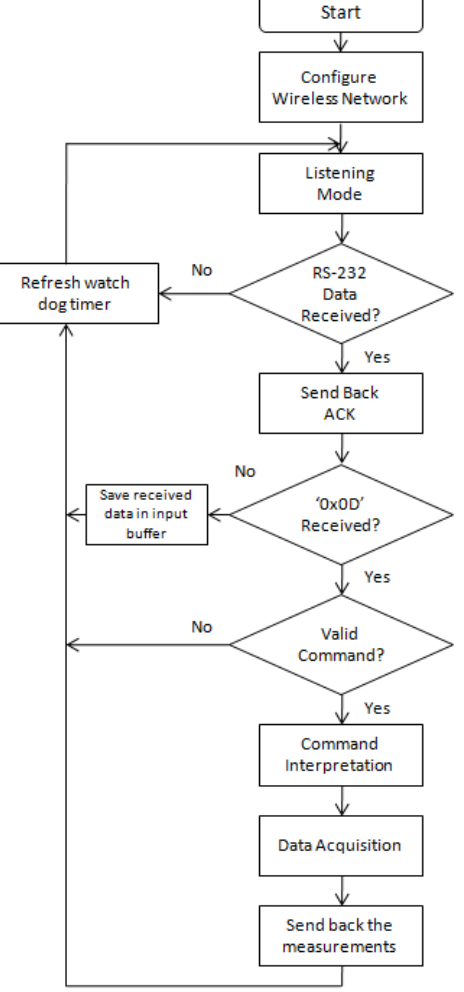
Figure 4. Flow diagram of the master